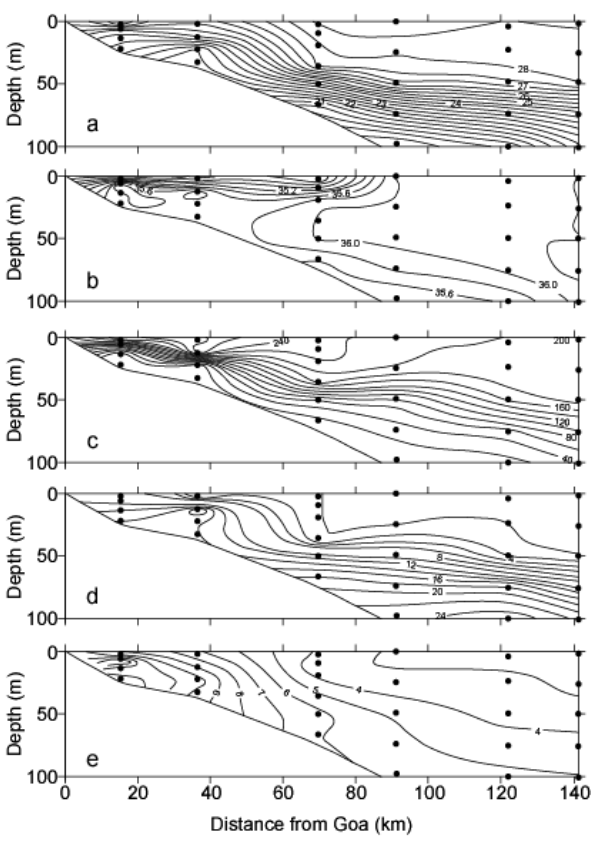
Fig. 3. Distribution of (a) temperature ( ◦ C), (b) salinity, (c) O 2 (µM), (d) NO − (µM), and (e) CH 4 (nM) off Goa ( ∼ 15.5 ◦ N, 3 73.75 ◦ E) during the Southwest Monsoon. Reproduced with per- mission from Jayakumar et al.